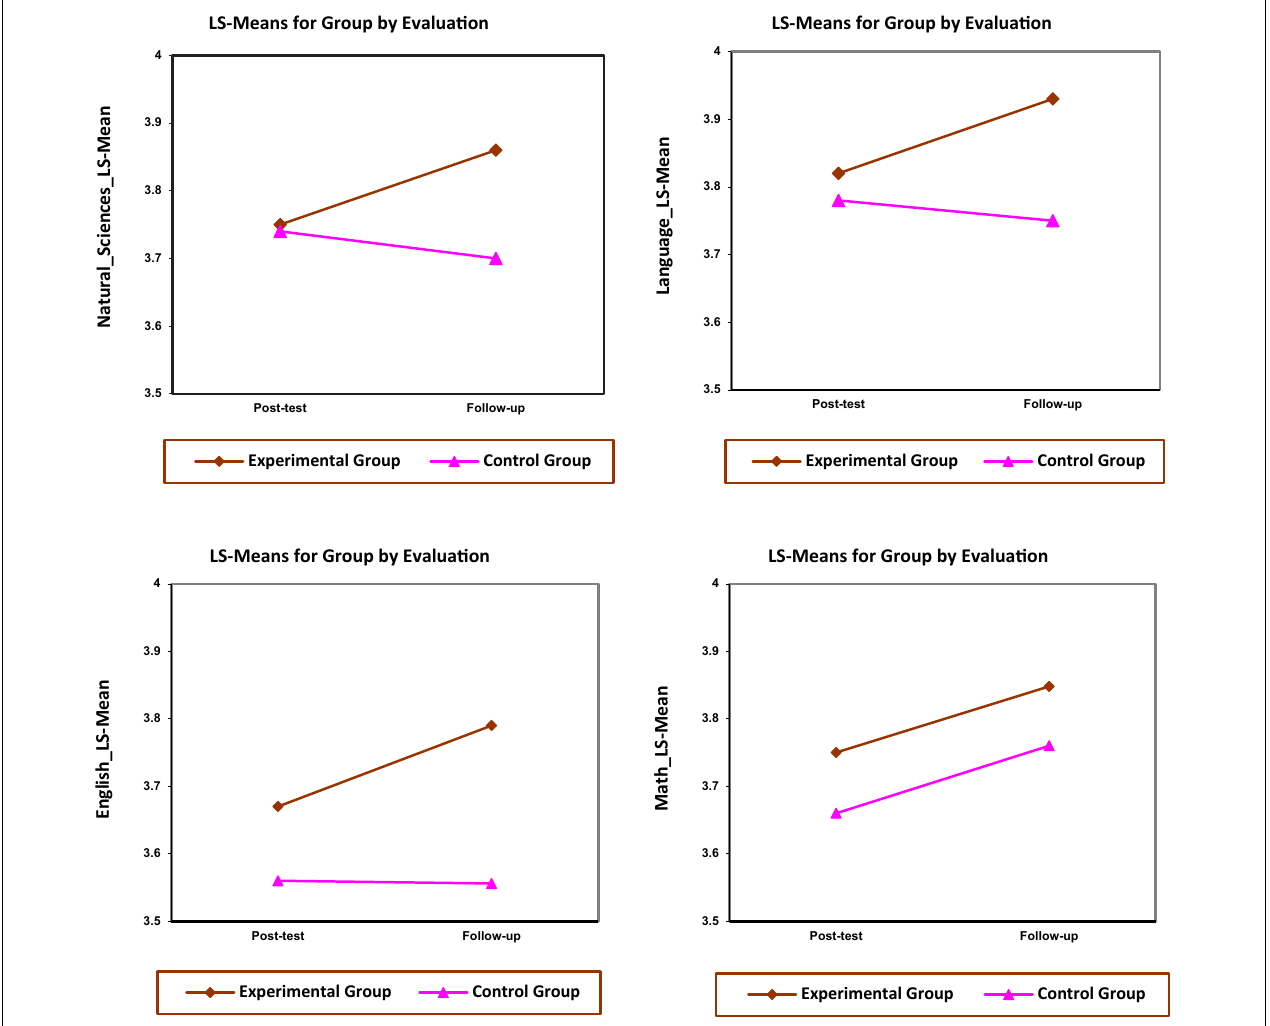
FIGURE 1 | Interactions plots: least-squares means over time by groups for each type of dependent variable (i.e., Sciences, Spanish language, English language, and